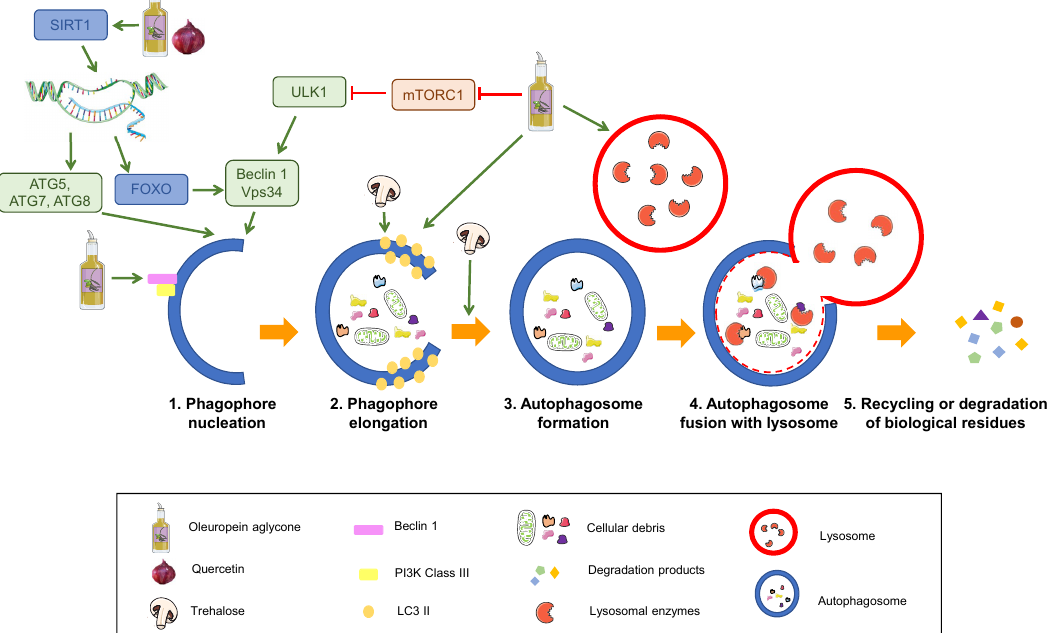
Figure 3. Stages of the autophagy process and its modulation by nutrients. Sequential steps of degradation by autophagy. SIRT1: Sirtuin 1. ATG: Autophagy-related protein. ULK1: unc-51 like autophagy activating kinase 1. FOXO: Forkhead box class “O” proteins. VPS34: Vacuolar protein sorting 34. mTORC1: mammalian target of rapamycin complex 1. Nutrients that are proposed to modulate autophagy are displayed in the legend. Green arrows represent activation. Red truncated arrows represent